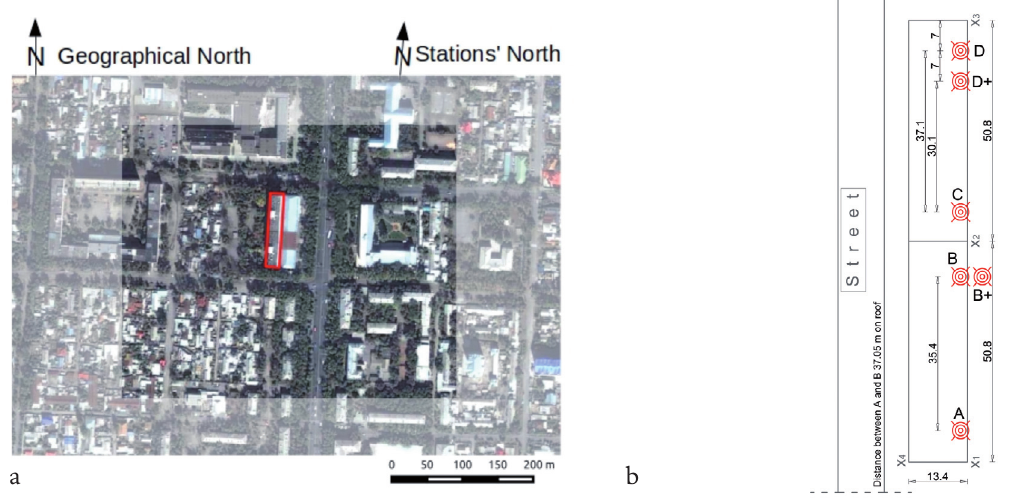
Figure 11. (a) Satellite image and (b) simplified building floor plan of 12 story RC building complex (Figure 2,VIII), showing the locations of the installed stations (red